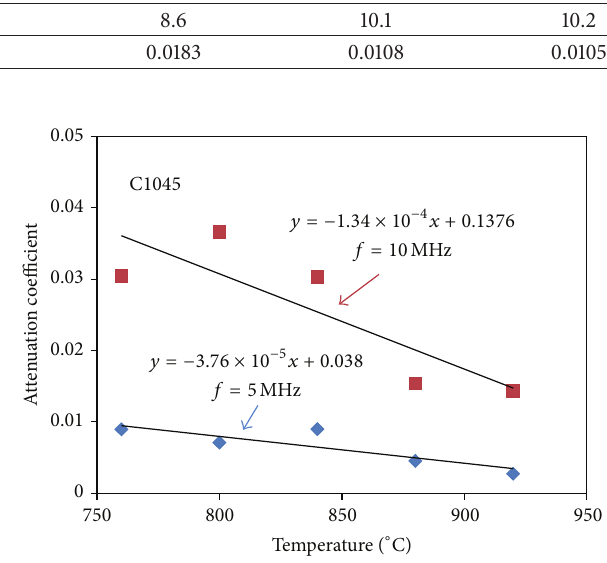
Figure 9: Attenuation coefficients of samples at different heat treatment temperatures using 5 and 10